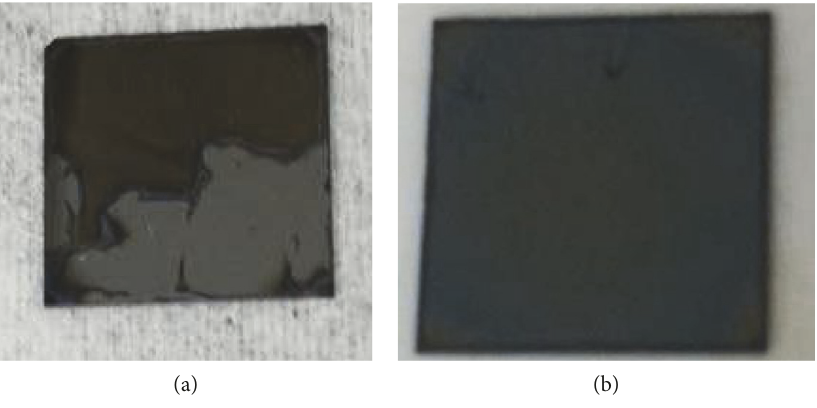
Figure 2: Photos (a) before and (b) after Triton X-100